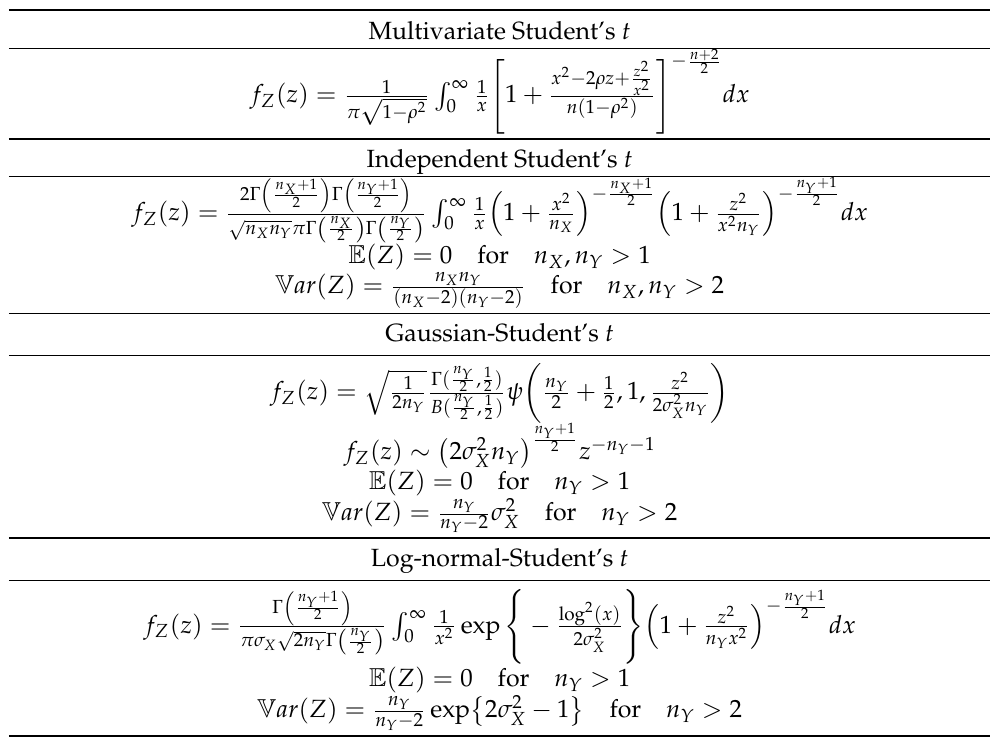
Table 3. Summary of the formulas for PDFs, f Z , its asymptotic behaviour for z → ∞ and two first moments, E ( Z ) and V ar ( Z ) for the considered products with Student’s t